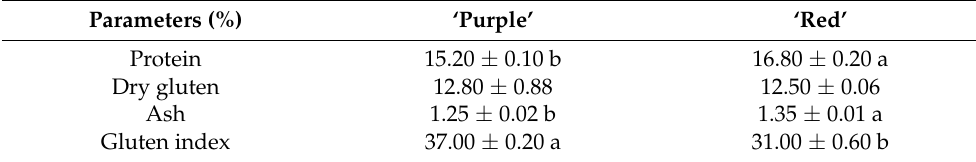
Table 1. Protein, dry gluten and ash content and gluten index in semolina of durum wheat ‘Purple’ and ‘Red’ landraces. Values are reported as mean ± SD ( n = 5). Significant differences between the two varieties for bran, semolina, or grain are indicated by lowercase letters ( t -test, p <